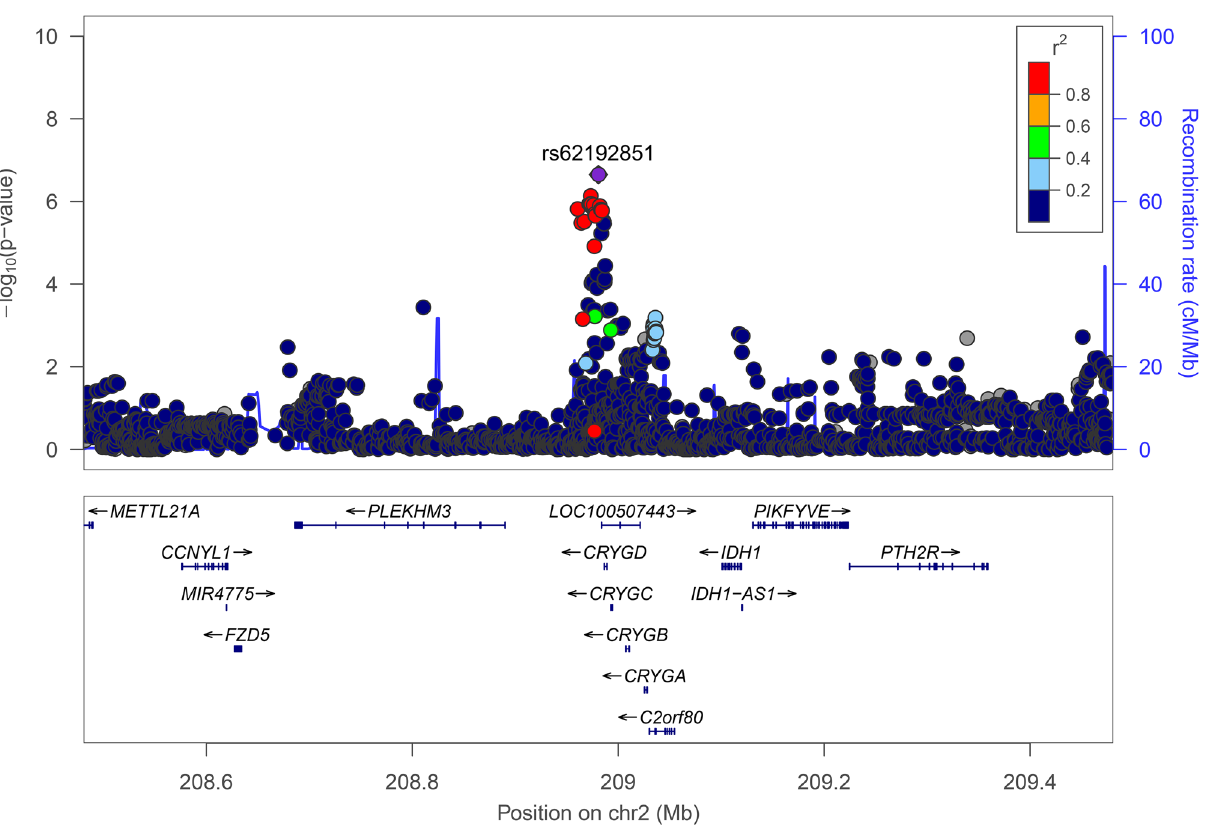
Figure 2. Regional locus zoom association plot of the associated region at rs62192851. The blue line denotes the recombination